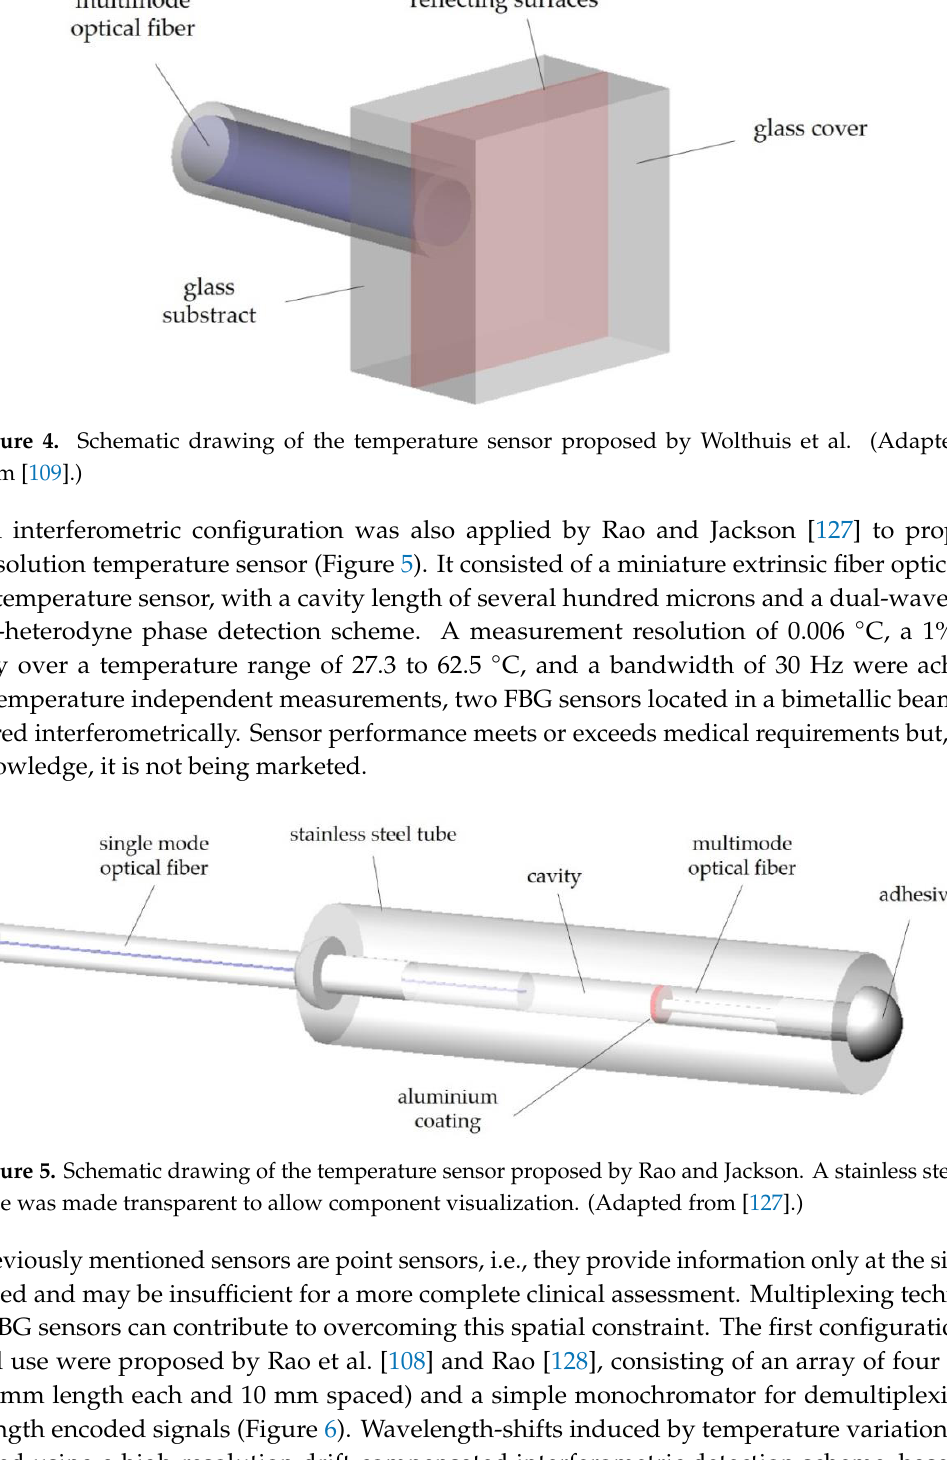
Figure 6. Schematic drawing of the temperature sensor proposed by Rao et al. (Adapted from [108].) A nylon sleeve was made transparent to allow component visualization. The above sensor was proposed for in vivo temperature monitoring during tumor therapy; in vivo trials occurred later using a similar configuration that was proposed by the same research group (Applied Optics Group, The University Canterbury, Kent, UK) [130]. A portable sensing unit with five in line FBGs was used. The source was a super luminescent diode (SLD) and the detector a miniature charge-coupled device (CCD) based spectrometer. Sensor resolution was 0.2 °C. This type of sensor was used to monitor hyperthermia treatments of the kidney and liver of rabbits [130,131]. Nevertheless, it was not applied in clinical settings because a nonlinear response of some FBG sensors and an initial system calibration drift exceeding 10 °C was reported [132]. To overcome these limitations, a polymer coated FBG (PFBG) probe was proposed [132]. It consisted of a 0.5 mm OD prototype with 10 FBG sensors at 5 mm intervals and 50 mm length. The PFBG sensor closely followed the behavior of well- established commercial hyperthermia thermometry probes. A swept wavelength laser-based readout system was capable to achieve 0.1 °C precision, while maintaining a better than 0.5 °C stability over